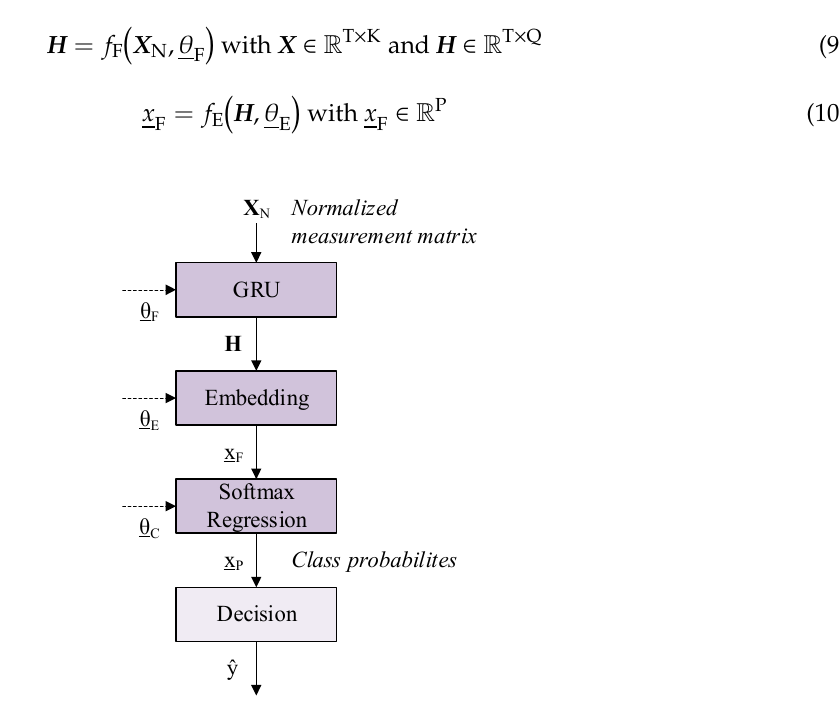
Figure 6. GRU based classification model with additional embedding function .